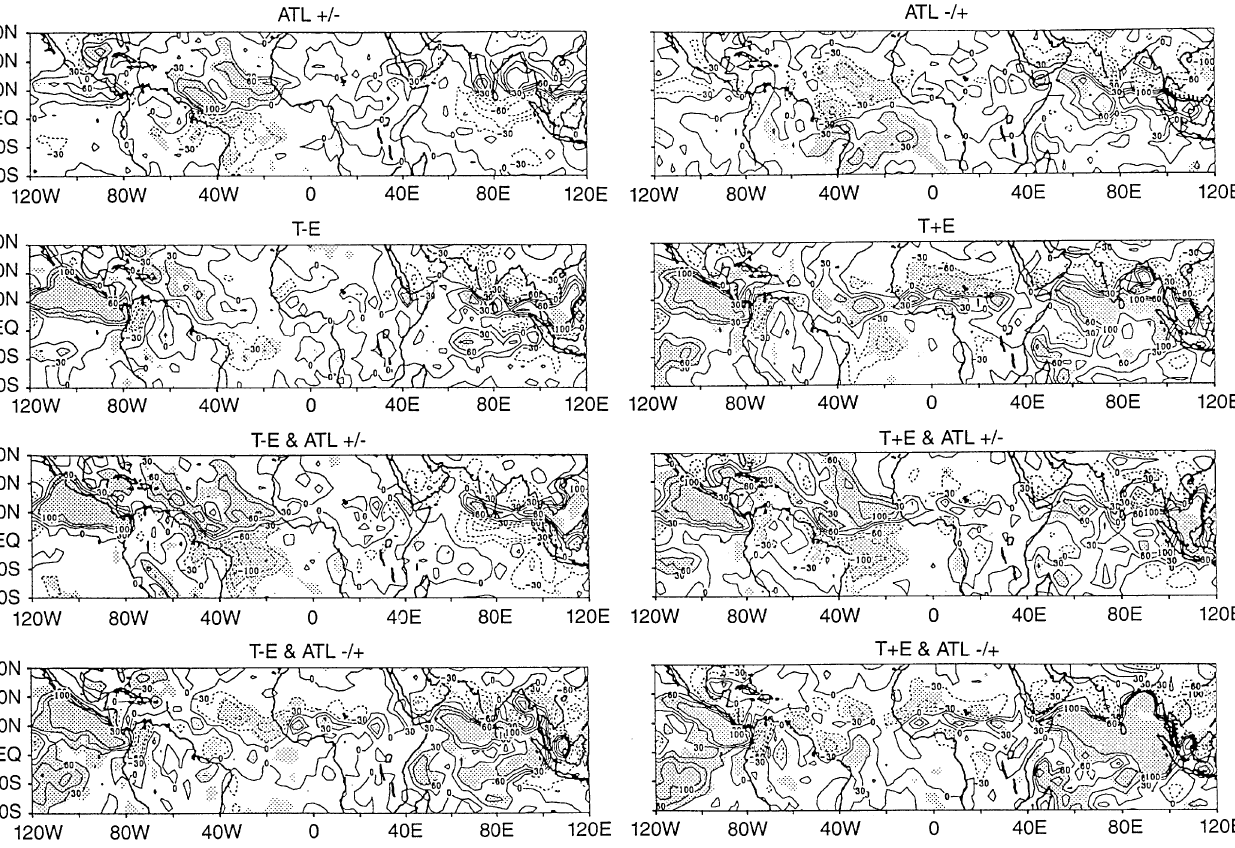
Fig. 5. Total precipitation monthly mean anomalies in regard to AMIP results. Positive (resp. negative) anomaly levels at 0, 30, 60,